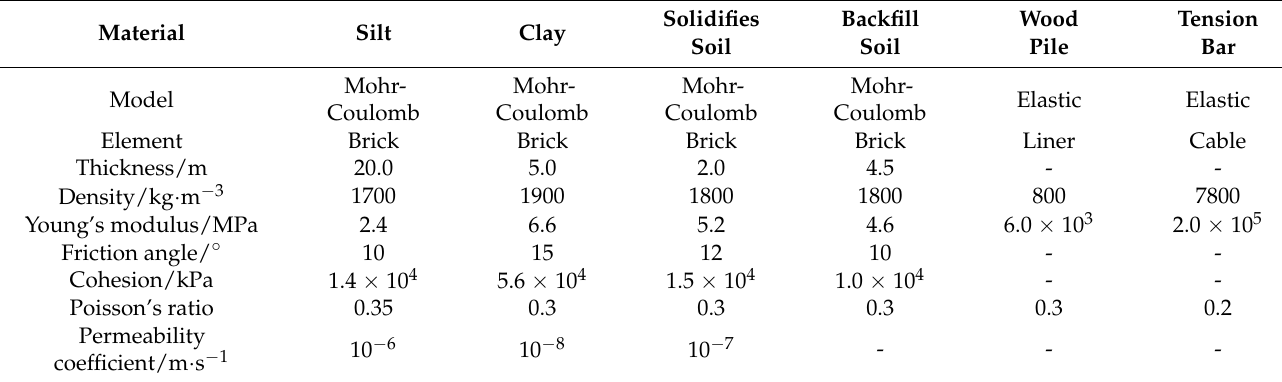
Table 1. Properties of the materials modeled in numerical